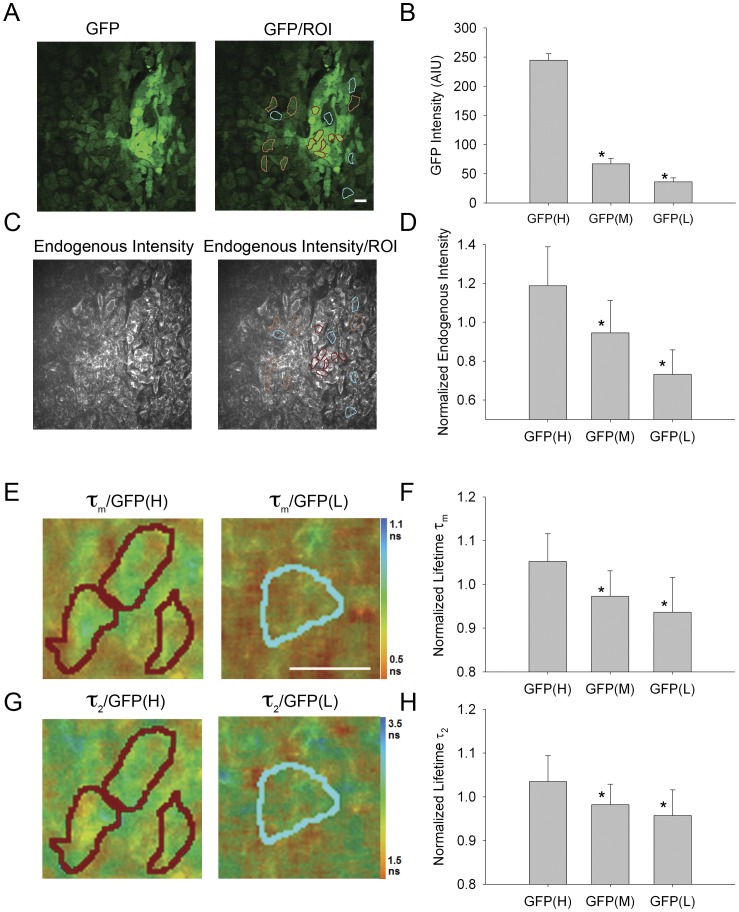
Cell level changes in endogenous fluorescence intensity and lifetime with loss of pluripotency of mESCs.A. GFP intensity of MPLSM single optical section of live mESCs expressing the pOct4:GFP transgene at 5 days post-EB formation using 890 nm excitation and 520/35 nm emission filter. Right image shows regions of interest (ROI), roughly corresponding to single cells, with high intensity GFP (GFP(H)) outlined with red; medium intensity GFP (GFP(M)) outlined with orange; low intensity GFP (GFP(L)) outlined with blue. B. Quantitative assessment of ROIs of GFP intensity. C. Intensity images of the same MPLSM single optical section as (A) using 780 nm excitation and 457/50 nm emission, corresponding primarily to NADH endogenous fluorescence. Right images show same ROIs as (A). D. Quantitative assessment of ROIs of endogenous intensity. E. Color mapped mean lifetime (τm) images of endogenous fluorescence showing the same ROIs, with quantitative assessment in F. G. Color mapped long lifetime (τ2) images of endogenous fluorescence with quantitative assessment of ROIs (H). Scale bars = 20 µm. Color bar indicates lifetime values for τm (E) or τ2 (G). * indicates significant difference between GFP(H) ROIs and ROIs of medium or low GFP intensity (P≤0.001; ANOVA on ranks followed by Tukey multiple pairwise comparison test at P<0.05).